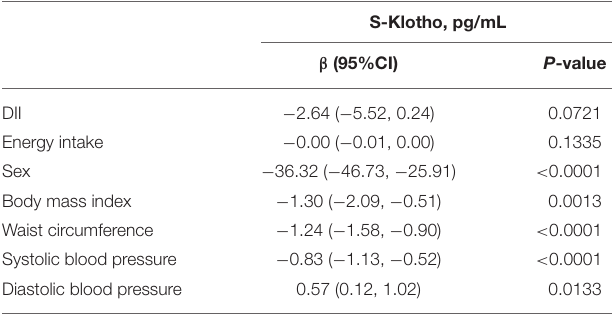
TABLE 2 | Univariate analysis for S-Klotho.